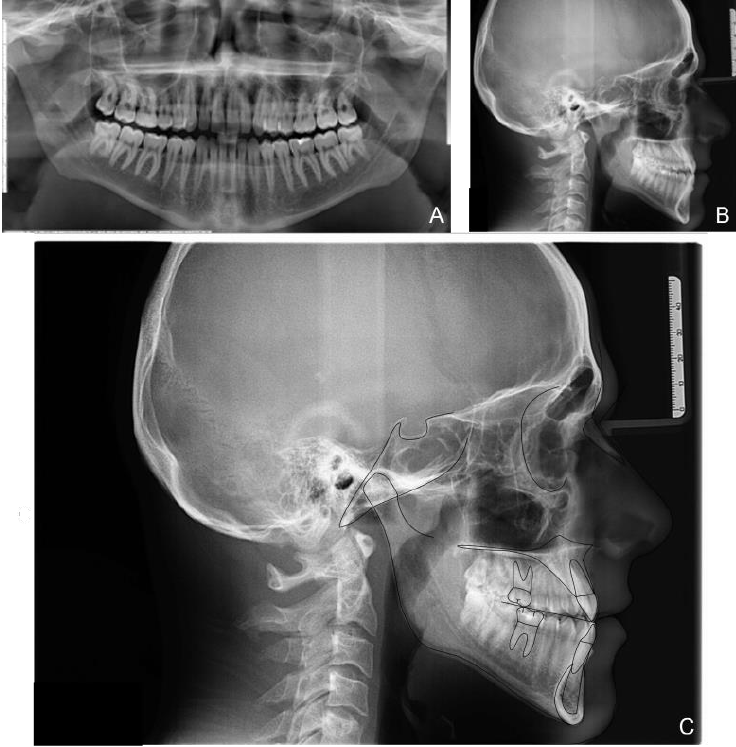
Figure 2. Patient X-rays, cephalometry tracing and analysis before treatment: panoramic X-ray ( A ); latero-lateral X-ray of the skull before treatment ( B ); Cephalometric tracing ( C ). Table 1. Cephalometric values before treatment .